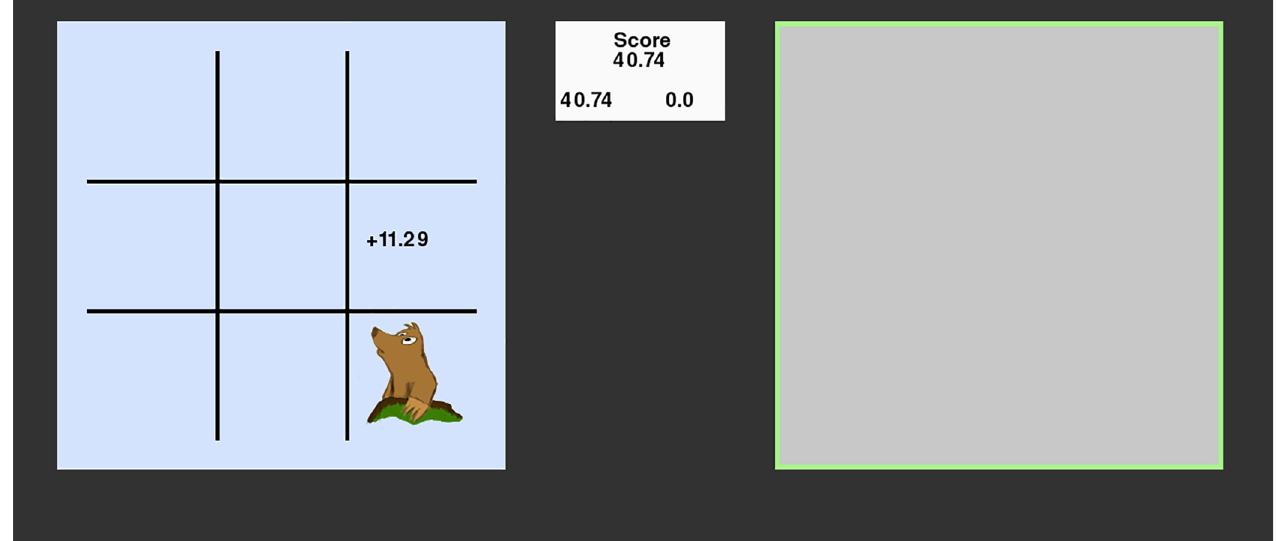
Fig 2. A screenshot from the Whack-A-Mole task in the dual